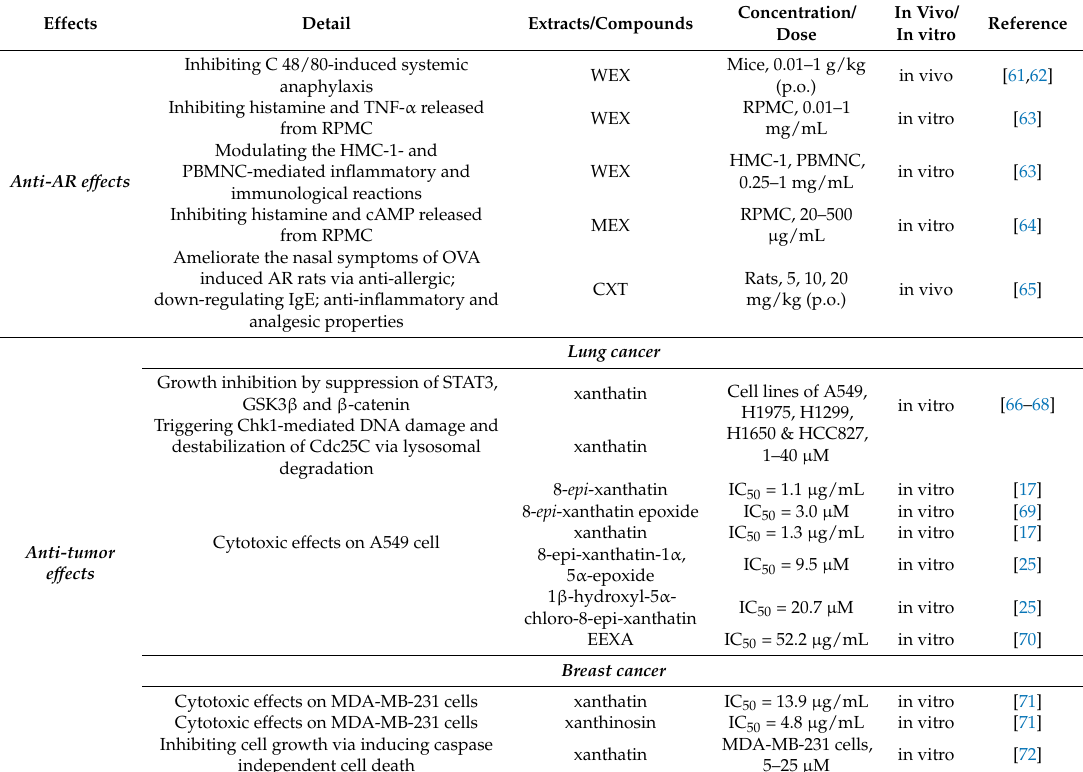
Table 3. Pharmacological effects of X.